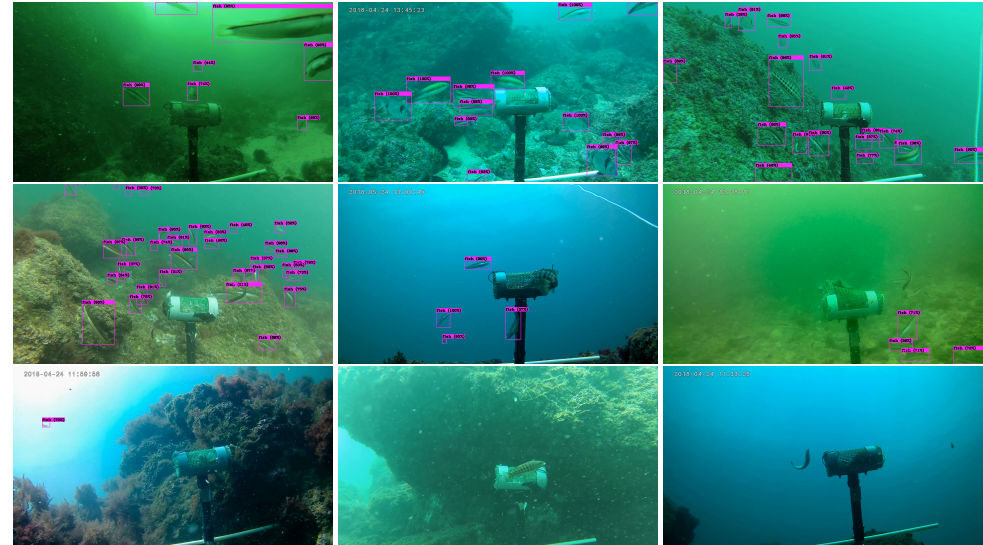
Figure 6. Sample of correct instant detections over frames obtained from the CCMAR footage. Top row: correct detections. Middle row: partially correct detections. Bottom row: failed